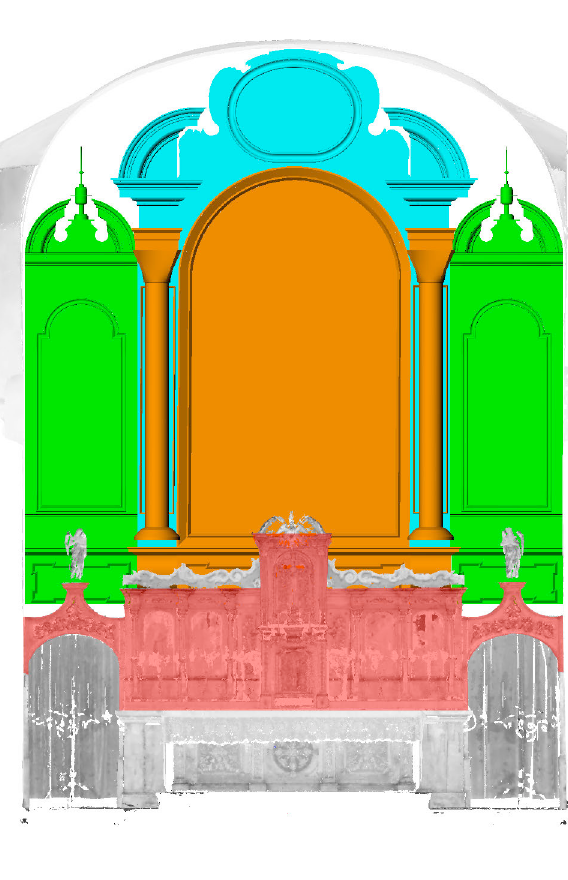
Figure 7: Classification of the elements. Color scheme: red: unchanged parts, orange: reused but dislocated parts, blue: missing but photogrammetrically reconstructed parts, green: parts reconstructed by geometrical analogy Locating the unchanged elements and the assumption that